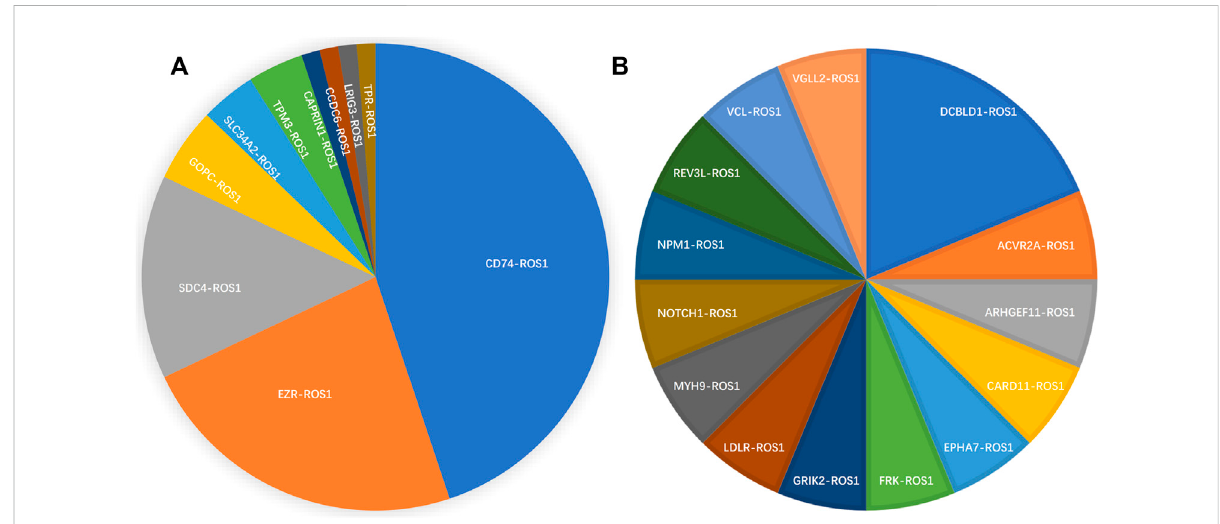
FIGURE 2 Spectrum of ROS1 fusion partners. (A) 10 reported ROS1 fusion partners. (B) 14 novel ROS1 fusion